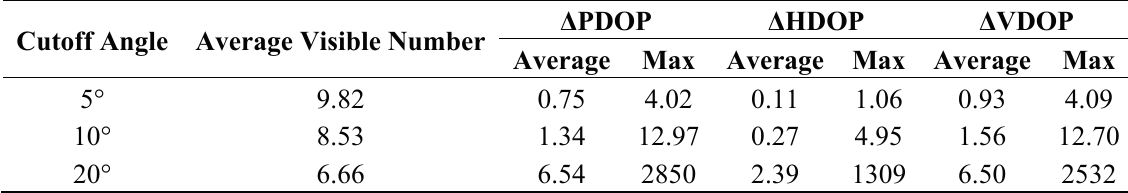
Figure 13. VDOP comparison at 20° cutoff. Table 3. DOP comparison between Ideal CSAC + GNSS and traditional GNSS.